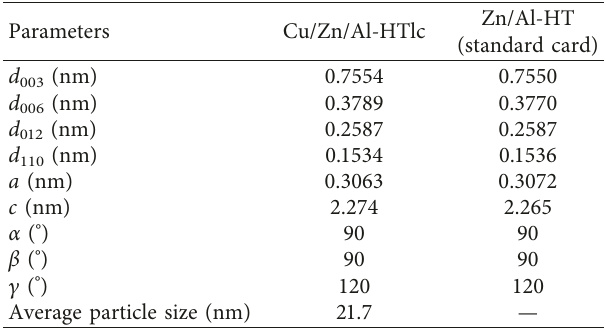
Table 1: The XRD diffraction parameters of Cu/Zn/Al-HTlc and Zn/Al-HT.